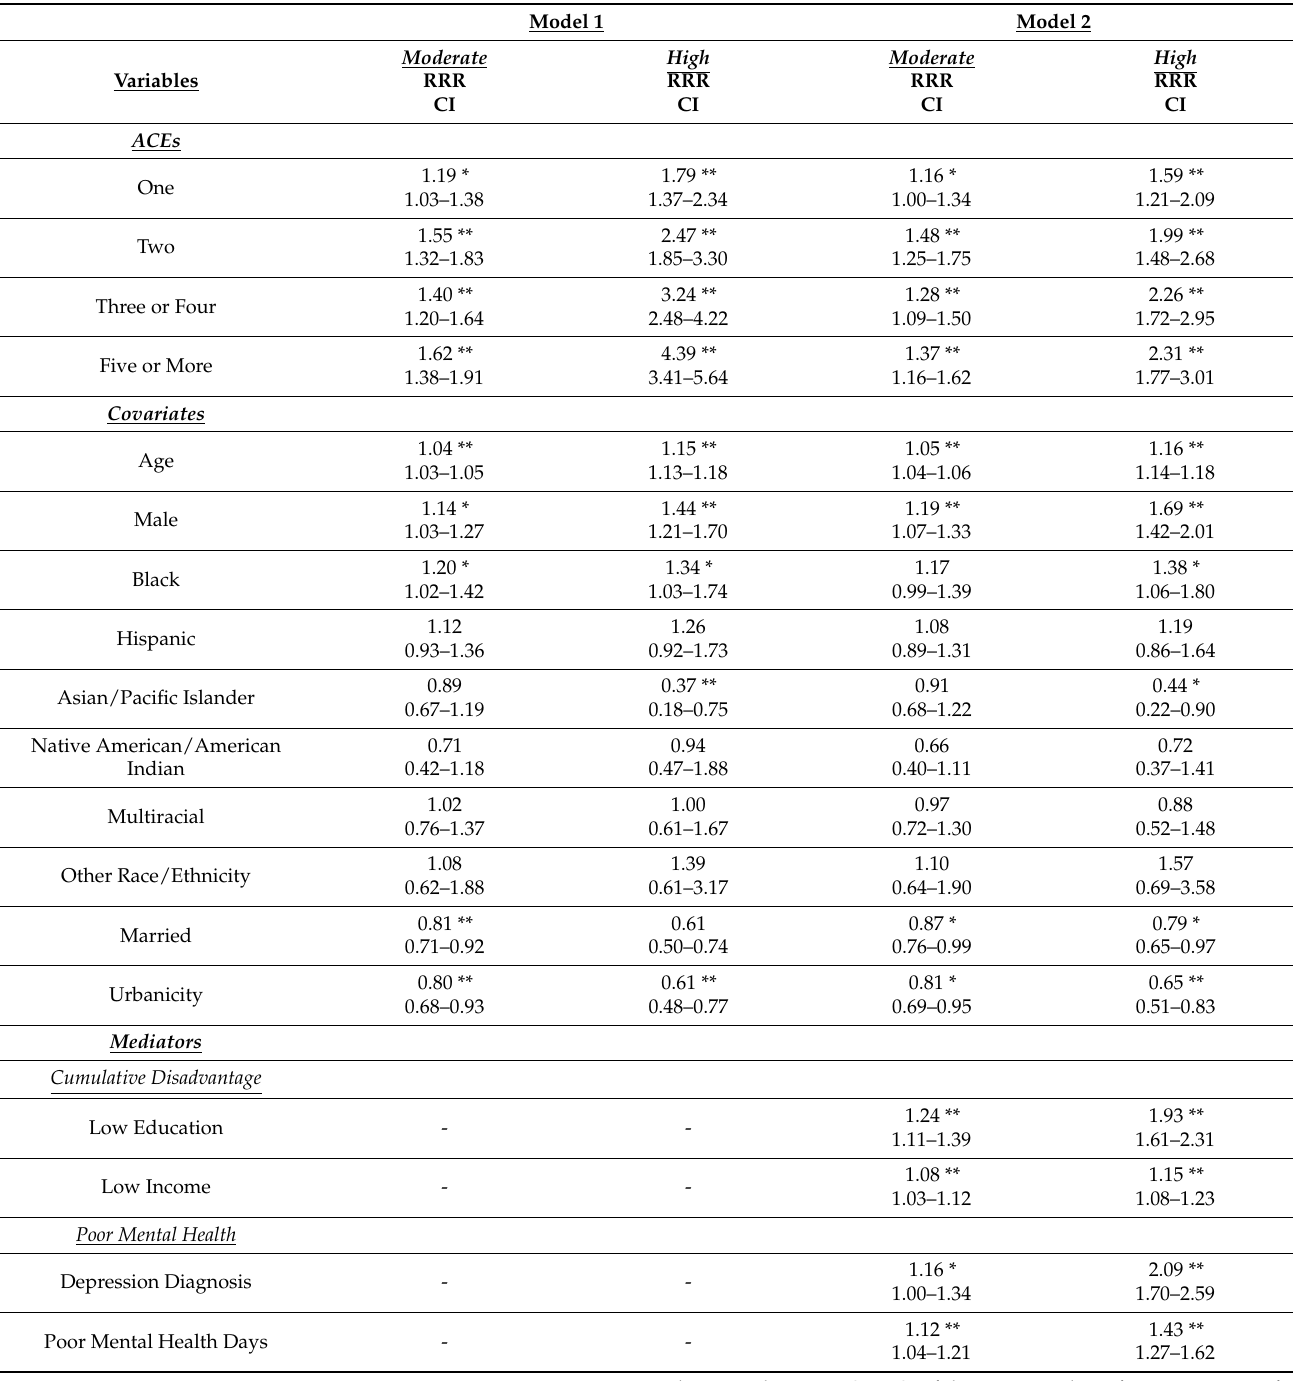
Table 2. Multinomial logistic regression models of the association between ACEs and cardiovascular risk among young adults aged 18–34 years ( n =